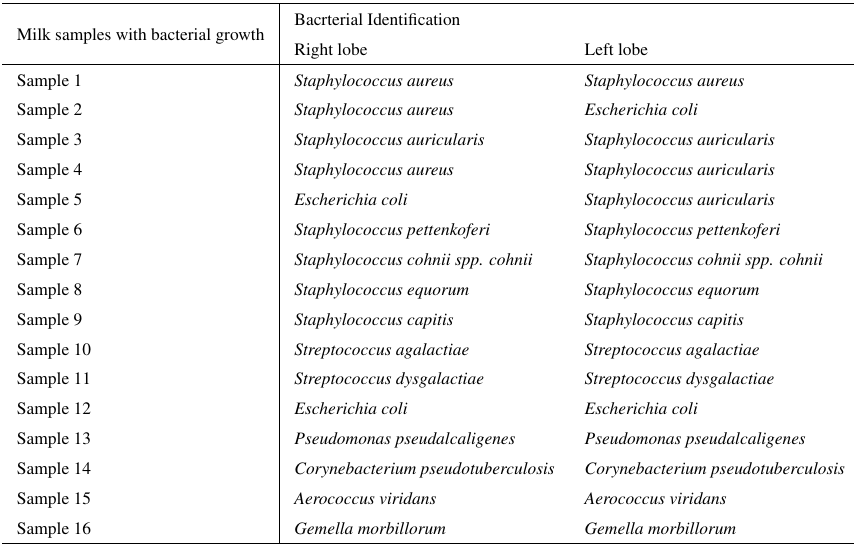
Table 2. The distribution of bacteria isolated from